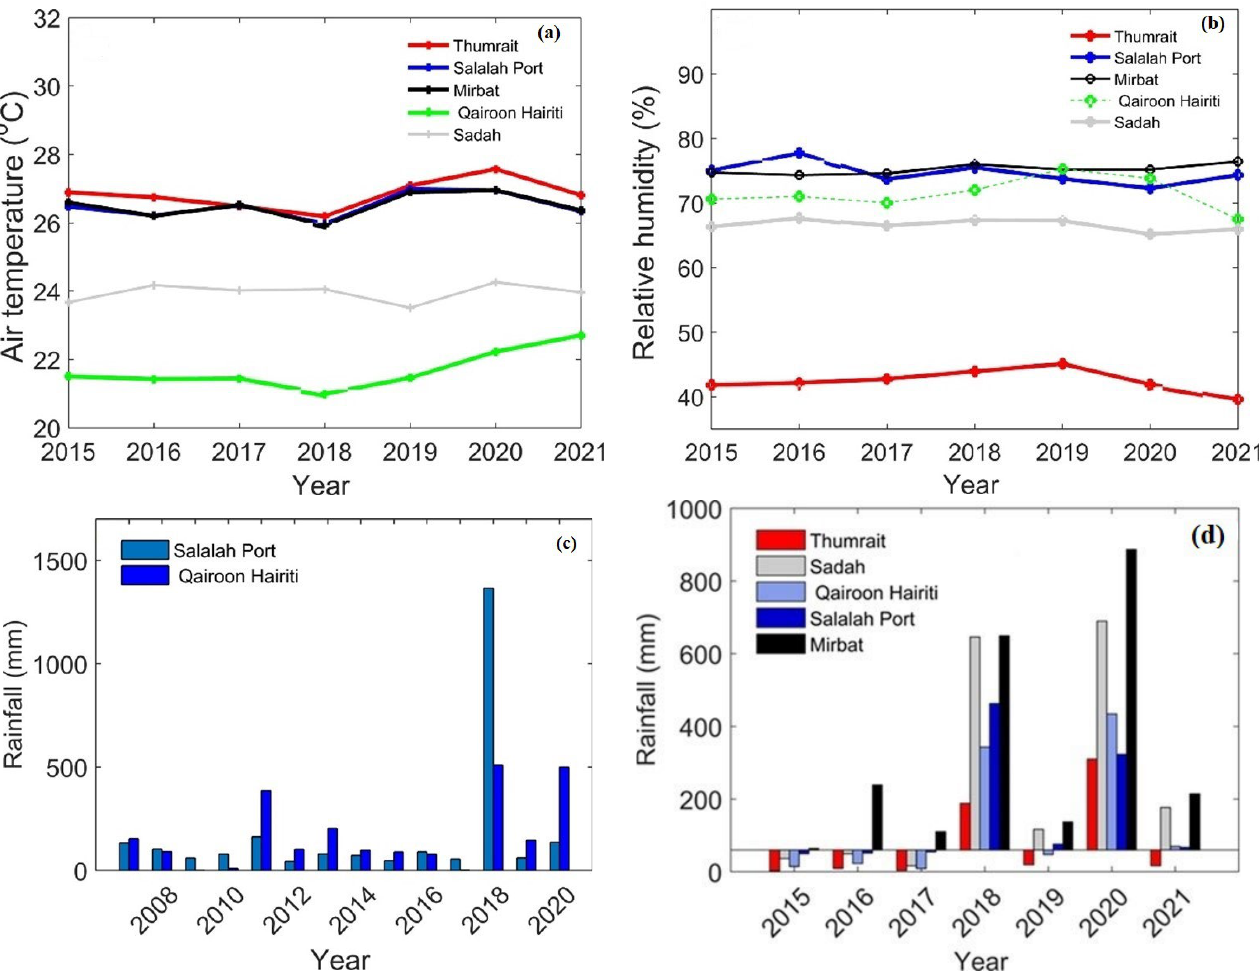
Figure 2. ( a ) Annual variations in air temperature from in situ observation, ( b ) variations in annual relative humidity from in situ observation, ( c ) annual accumulation of rainfall (mm) from in situ observation (Qairoon Hairiti and Salalah Port), and ( d ) total accumulation of rainfall from the ERA5 model.